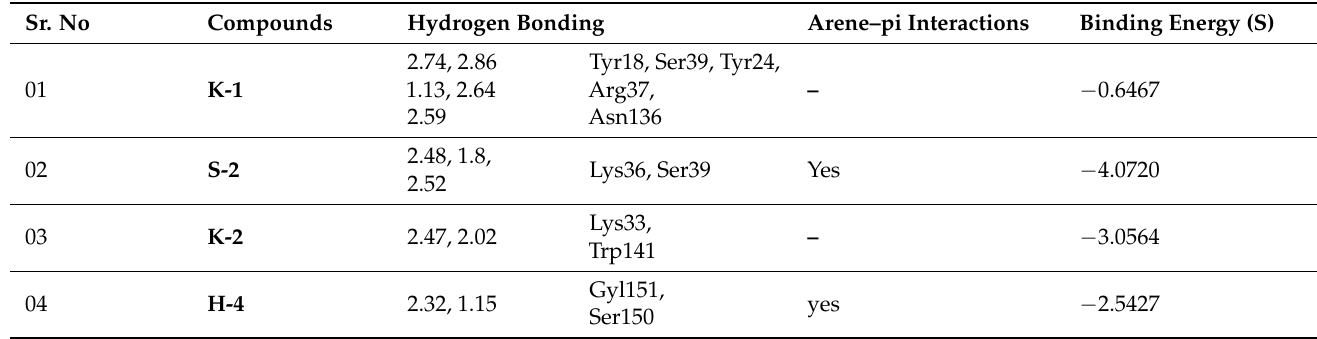
Table 4. Binding interactions and binding energy of synthesized compounds.